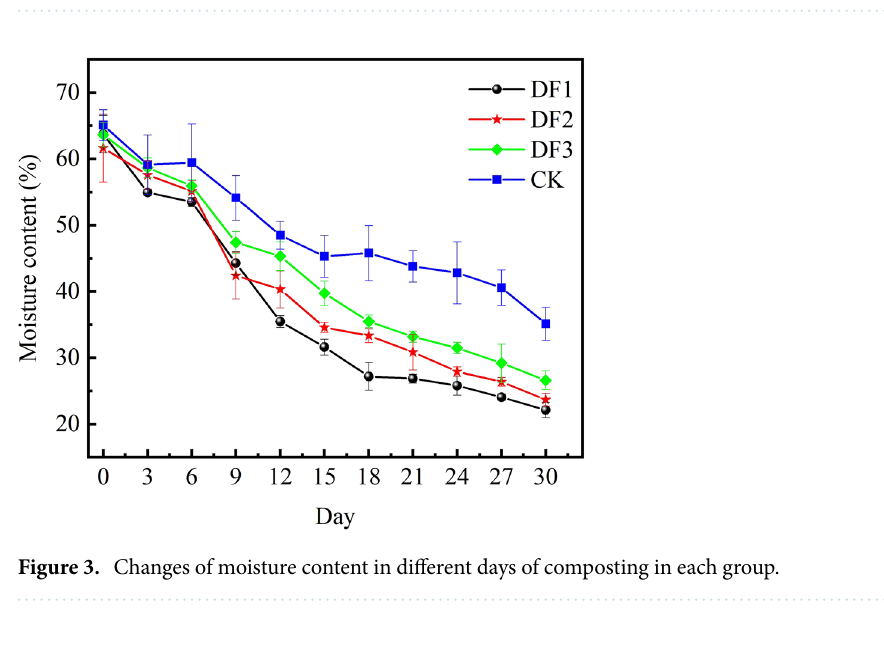
Figure 2. Changes of pH in different days of composting in each group.